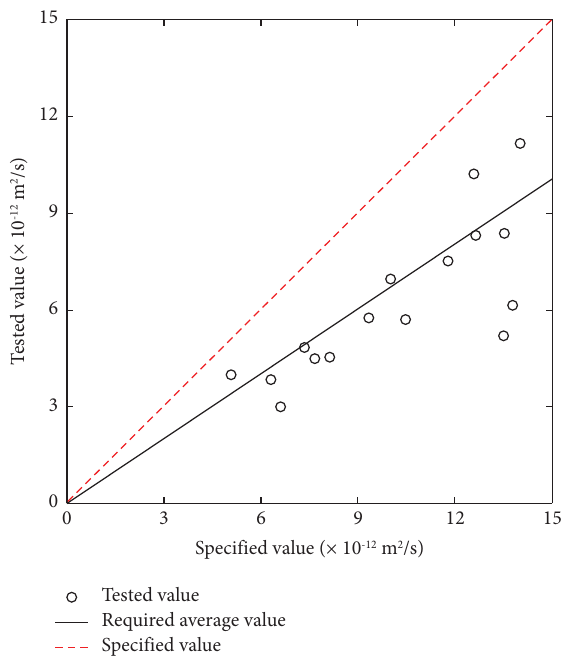
Figure 4: Chloride difusion coefcient of